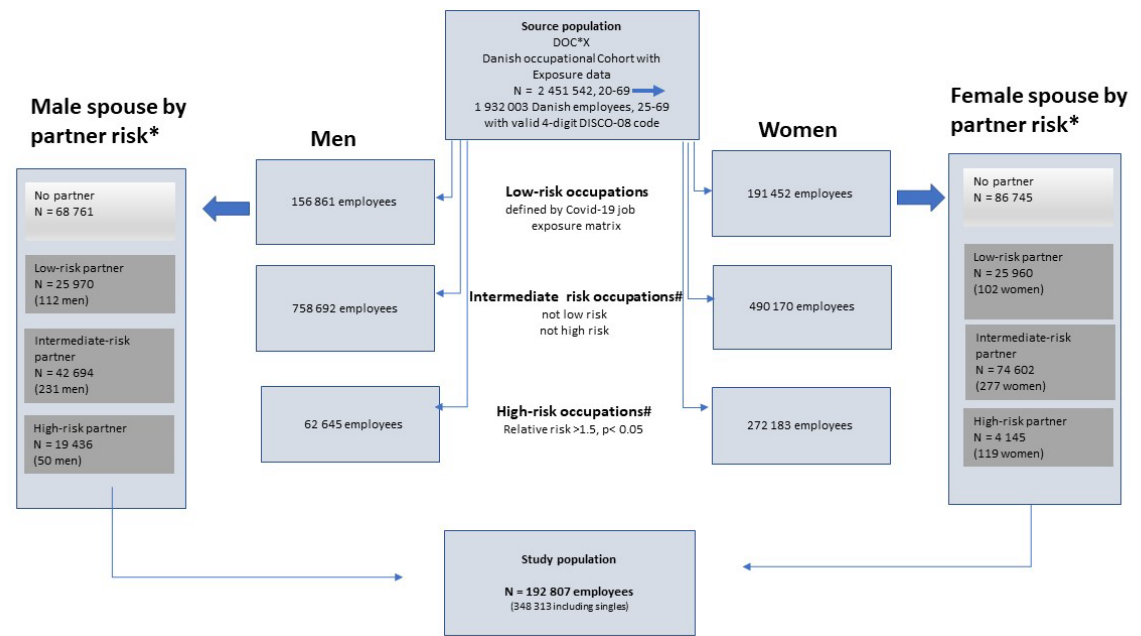
Figure 1. Identification of spouses (low-risk occupations) to partners in low-, intermediate- and high-risk occupations based upon the DOC*X cohort. * Including partners of same sex. # High-risk occupations were derived from sex-stratified follow-up analyses of adjusted risk of COVID-19 hospital admission (Poisson regression providing incidence rate ratios) by all 4-digit DISCO-08 job codes using the entire source population [N=2 451 542, results provided in supplementary table 1, methods detailed in